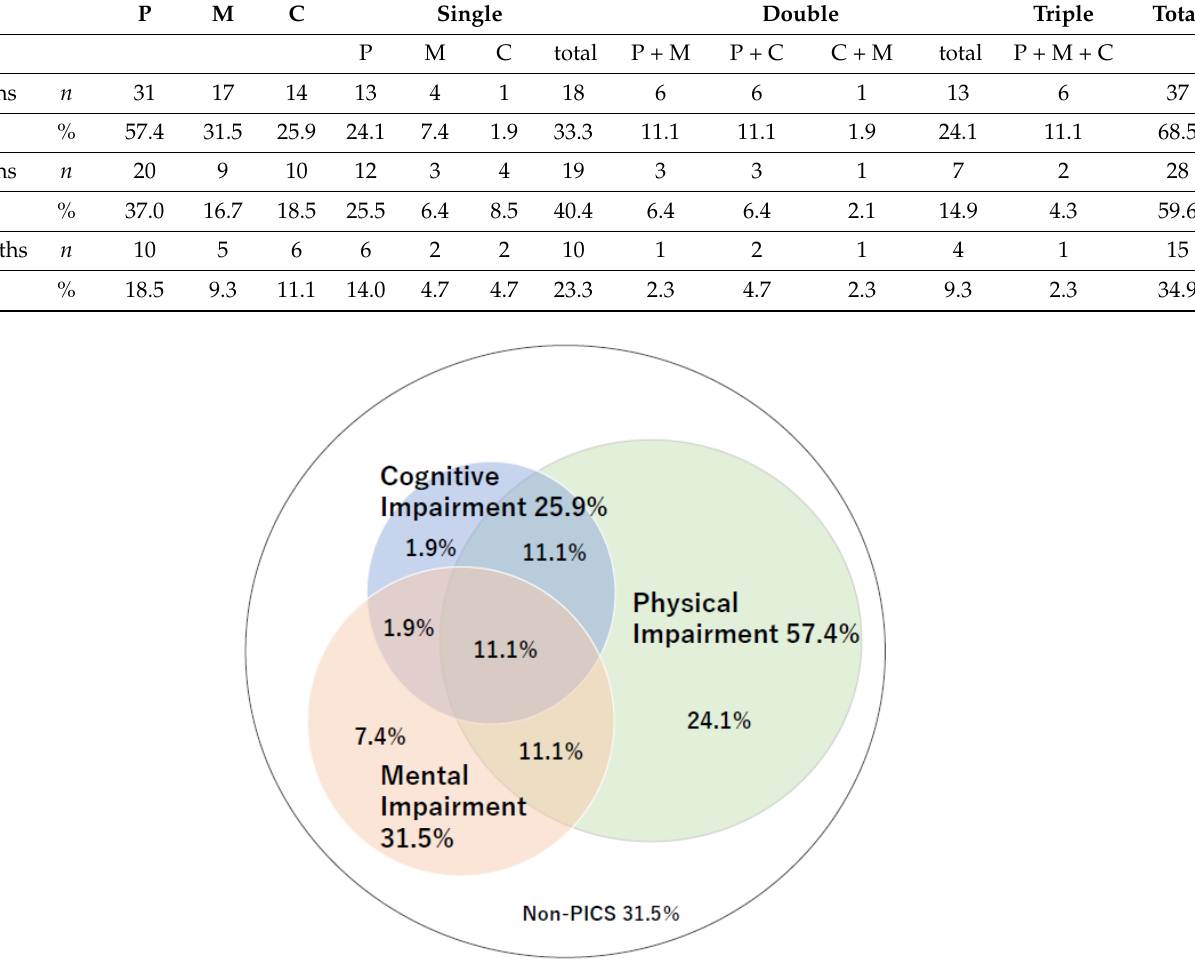
Figure 3. The prevalence of post-intensive care syndrome (PICS) at 3 months after ICU discharge. Table 3. The prevalence of each PICS domain at 3,6,12 months after ICU admission in septic patients.